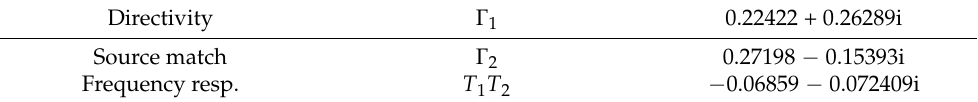
Table 3. Complex error terms determined from the free-space calibration procedure—f = 10